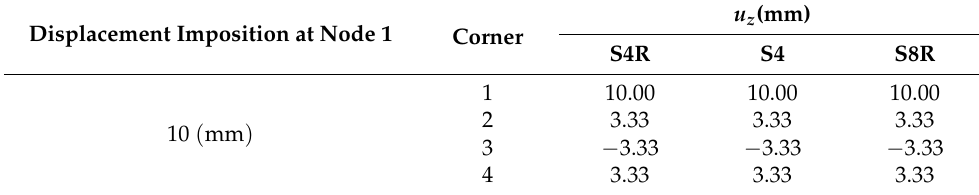
Table 5. Displacement along z -direction for different FE types.